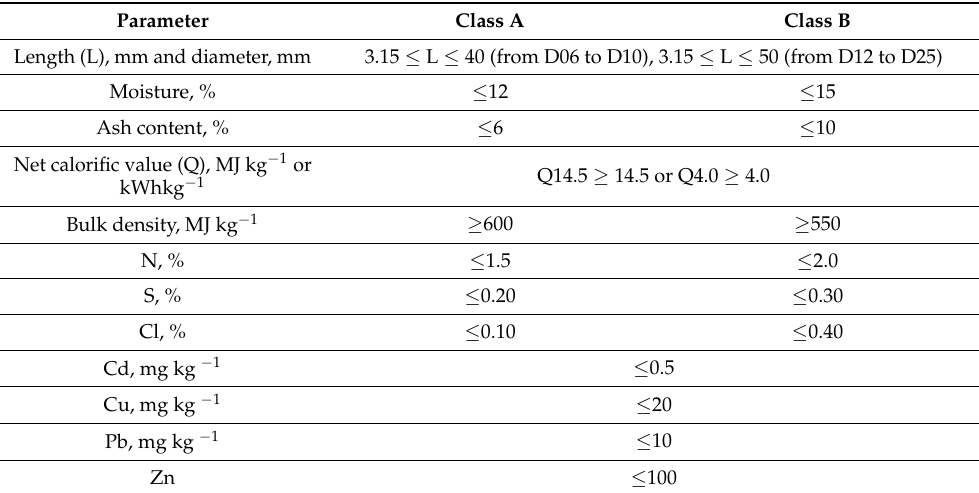
Table 3. ISO 17225-6 requirements for non-woody pellets *.